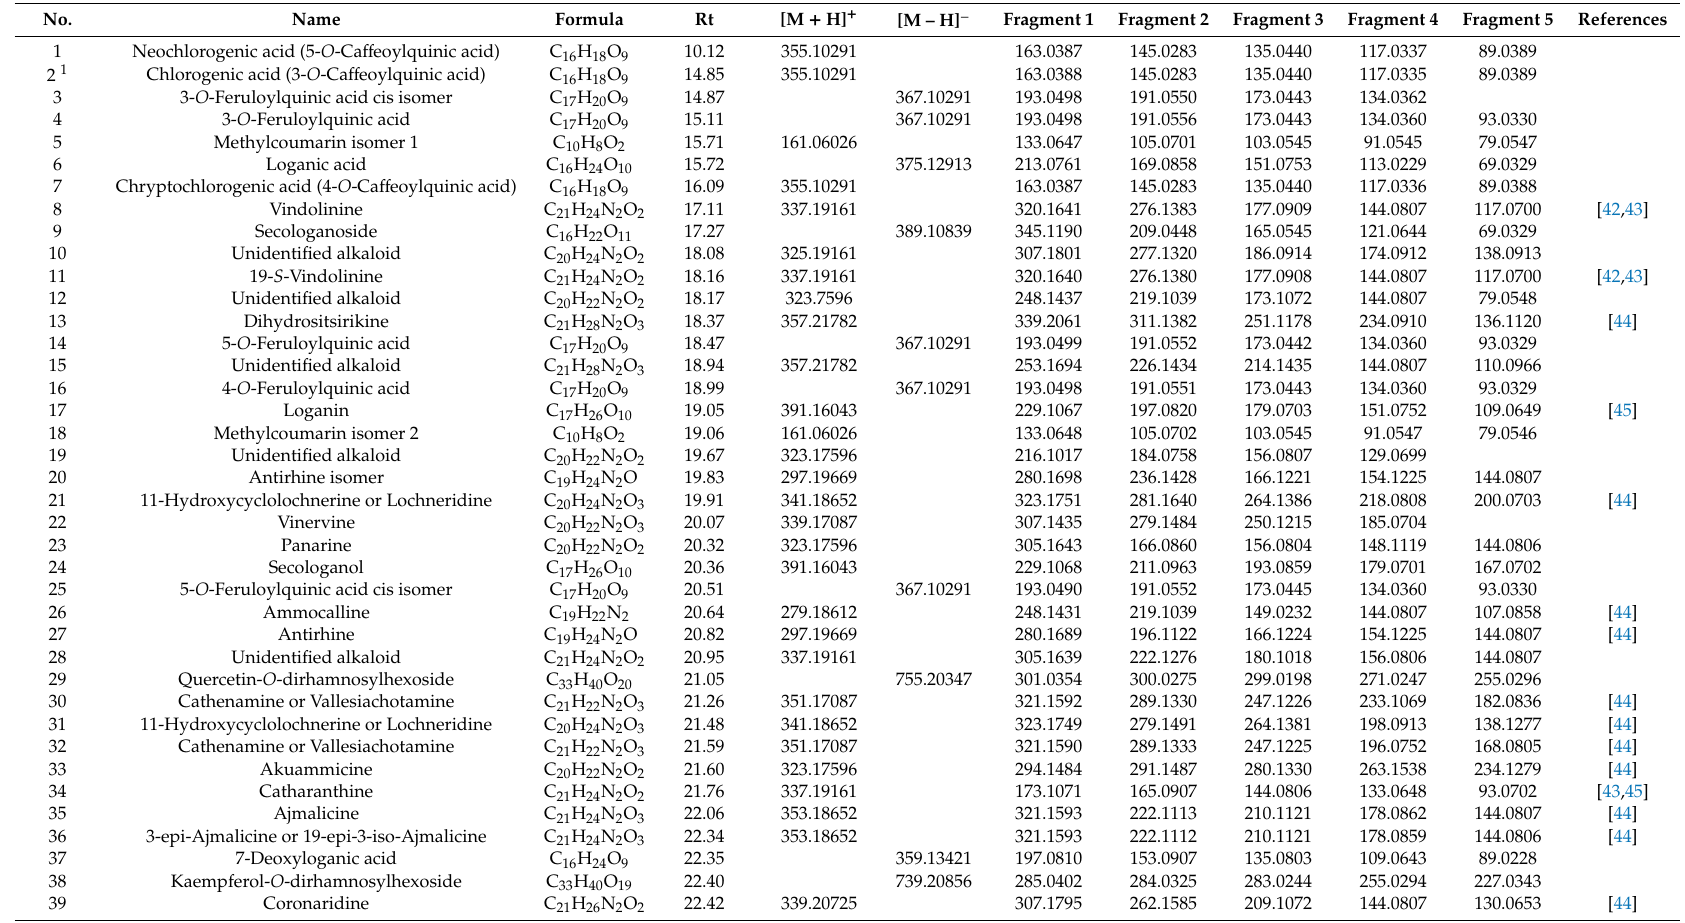
Table 9. Chemical composition of somaclonal variant shoot tissues of Catharanthus roseus